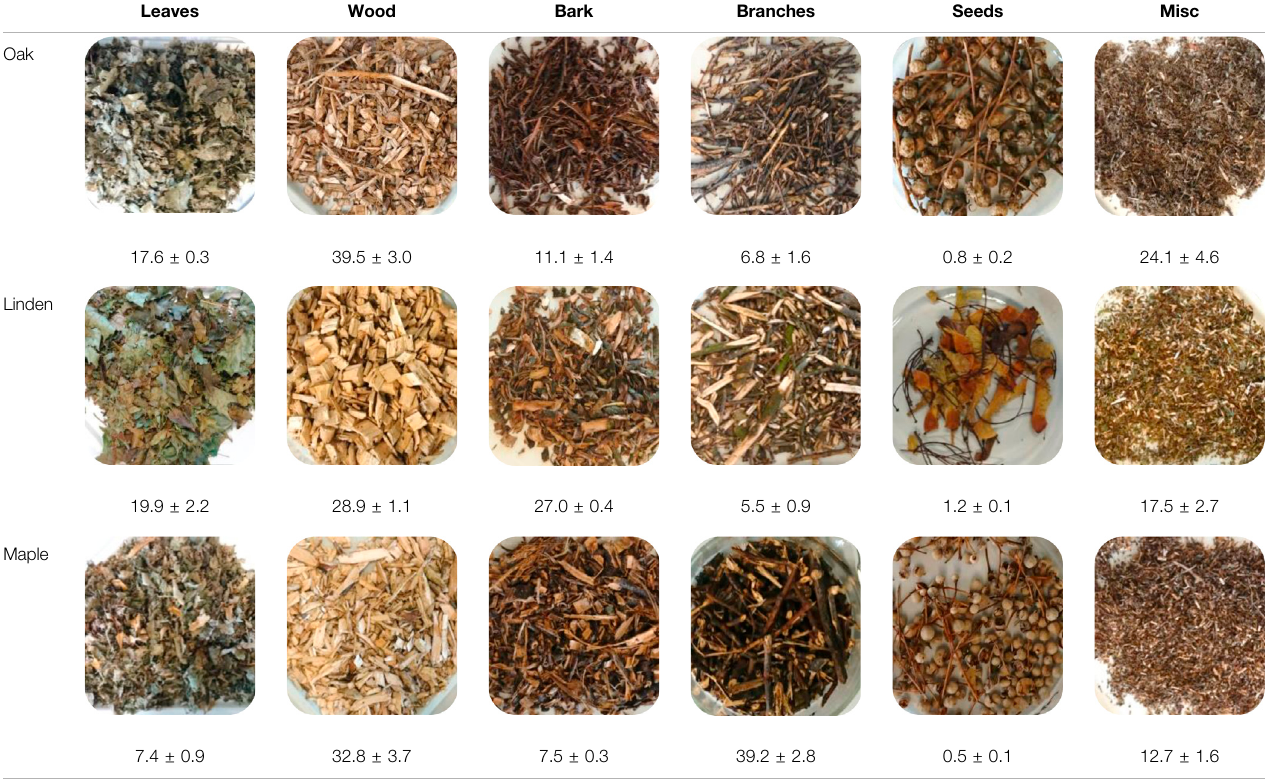
TABLE 1 | Composition of the tree pruning material collected in the summer [(% w/w), mean (SD), n (cid:1) 3]. Leaves Wood Bark Branches